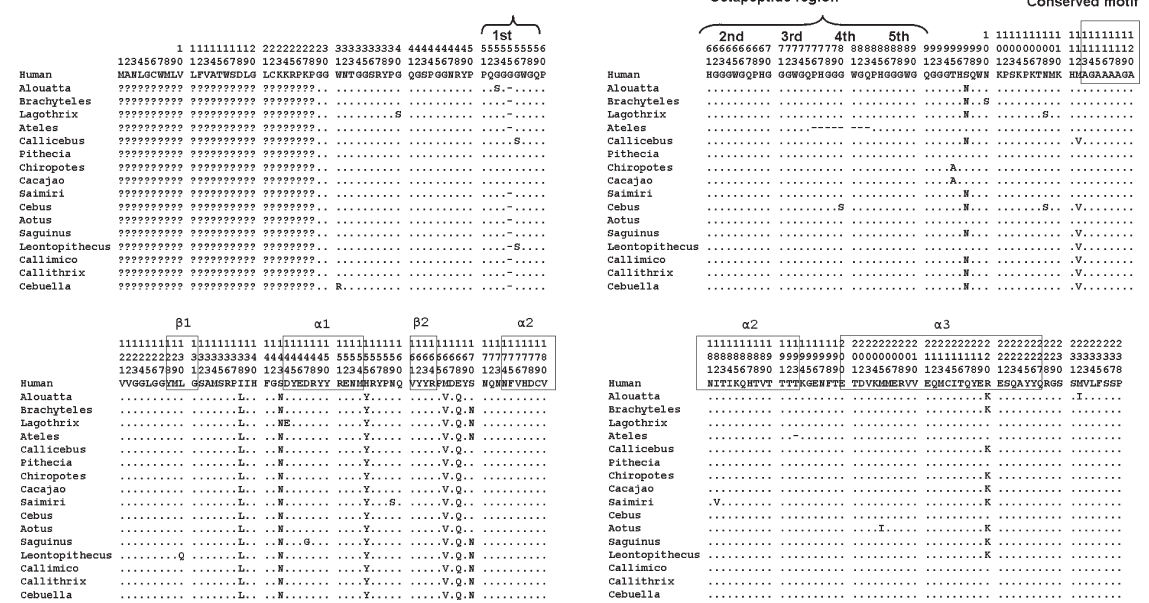
Figure1 -Alignmentofthe239deducedaminoacidsequencesofPrPs.Thenon-humanprimatesequenceswerecomparedtothehumanPrP.Dotsrepre- sent amino acids that are identical with human and question marks means missing data. Boxes represent alpha and beta helix domains.